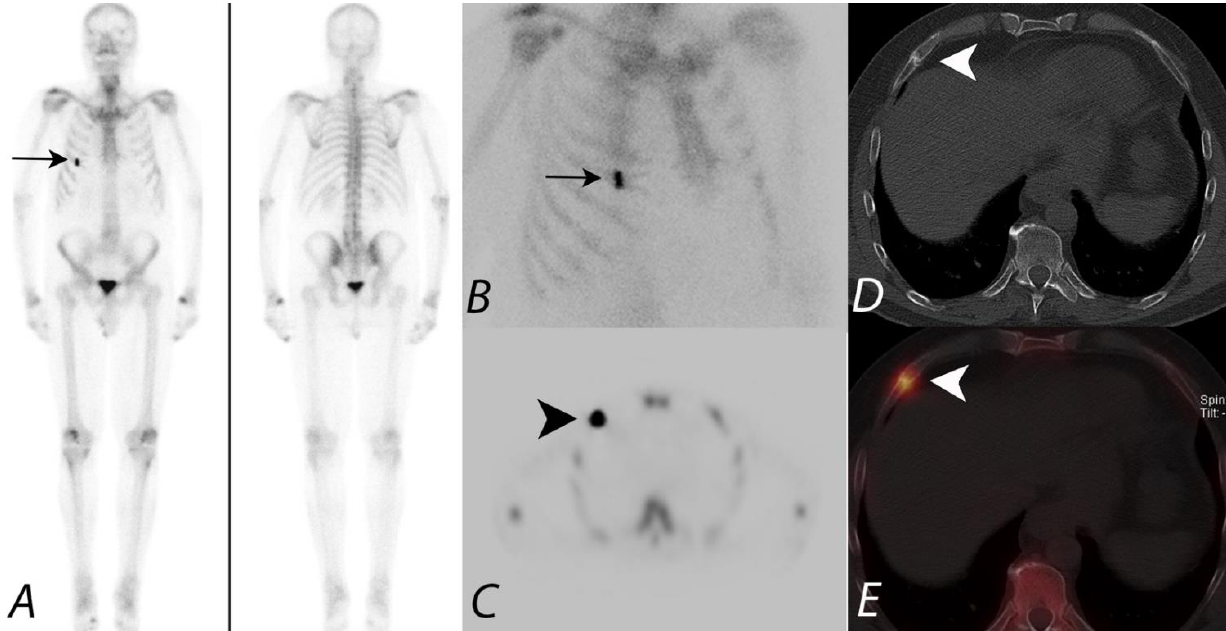
Figure 6. Patient presenting with prostate cancer underwent 99m Tc MDP bone scan to evaluate for metastatic disease. Whole body image in anterior projection ( A ) showing focal increased tracer uptake along the anterior aspect of the right sided 5th rib, confirmed on planar oblique image ( B ) (black arrows). SPECT image ( C ) demonstrates focal uptake along the 5th rib anterior aspect (black arrowhead). However, it is unclear if this focus represents a solitary metastatic disease versus another process, such as trauma. Axial CT ( D ) at the same level provides anatomic information showing a healing fracture (white arrowhead). Fused SPECT/CT image ( E ) accurately registers the focal activity (white arrowhead) identified on the planar image and SPECT images to the healing fracture on CT image — a great advantage of the hybrid SPECT/CT imaging combining the functional information with anatomic information.